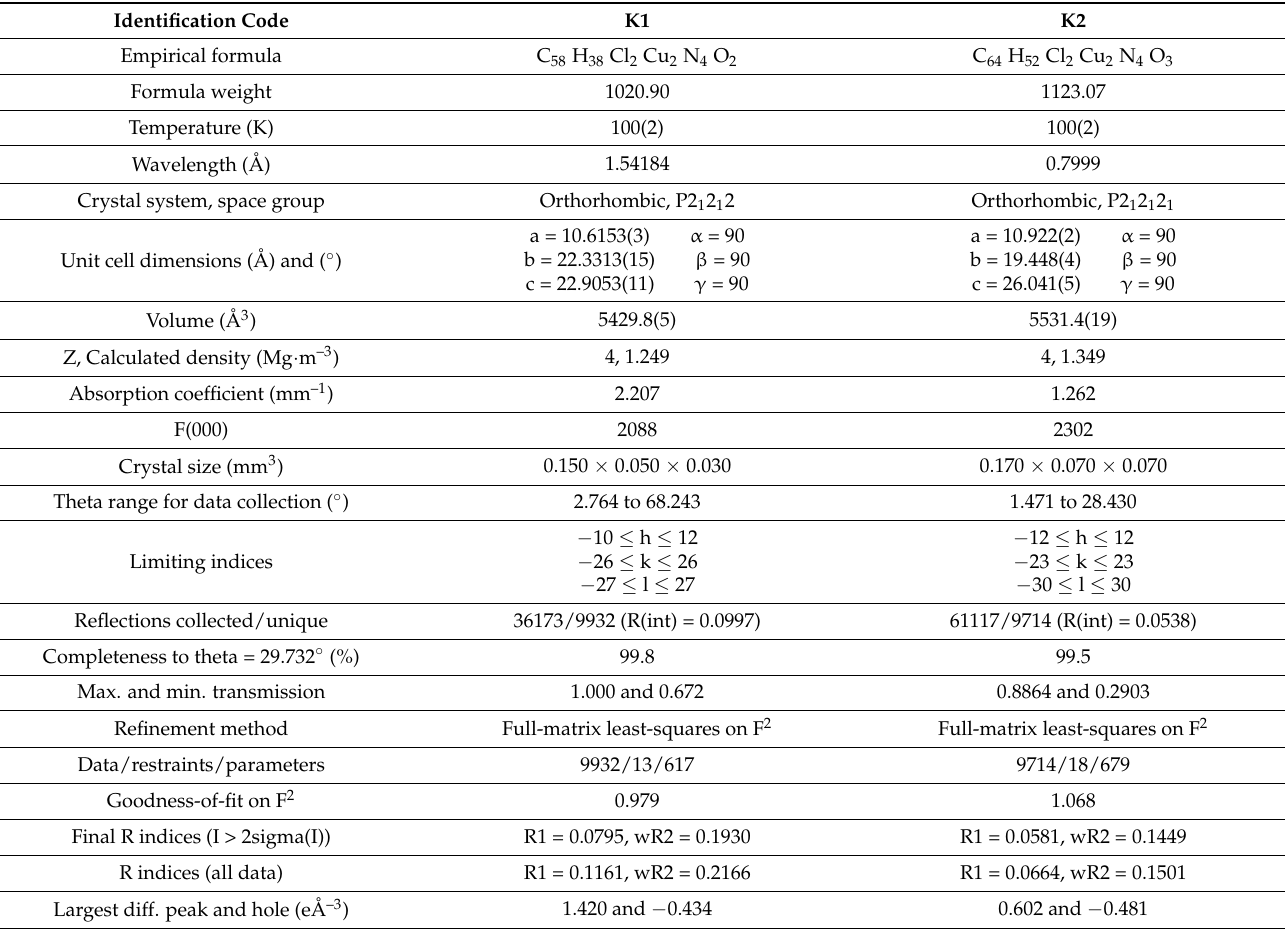
Table 5. Crystal data and structure refinement for K1 and K2